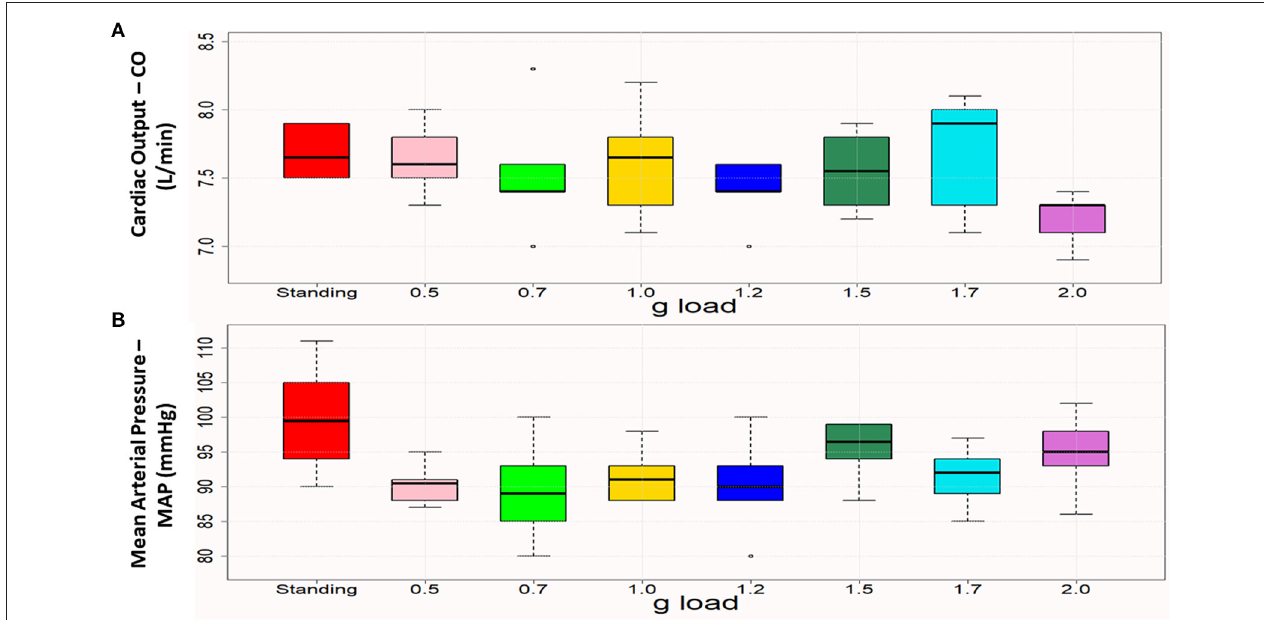
FIGURE 2 | Boxplots of cardiac output (A) and mean arterial pressure (B) in standing and the various (0.5–2.0) g loads. Each box represents the interquartile range, and the centerline represents the median. Whiskers are extended to the most extreme data point that is no more than 1.5 times the interquartile range from the edge of the box (Tukey style). Dots represent outliers. Cardiac output was close to the standing values at 1g and 1.5g, and mean arterial pressure was closest to the standing value at